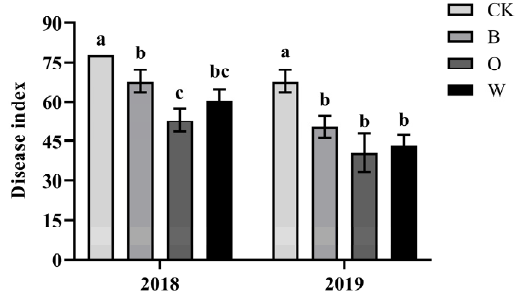
Figure 2. Disease index of Chinese cabbage planting for 40 days. CK represents Chinese cabbage continuous cropping; B, O, and W represent bean, potato onion and wheat rotation respectively. Different letters are significantly different; the results are for the statistical analysis within each year ( p < 0.05, Tukey’s HSD test).